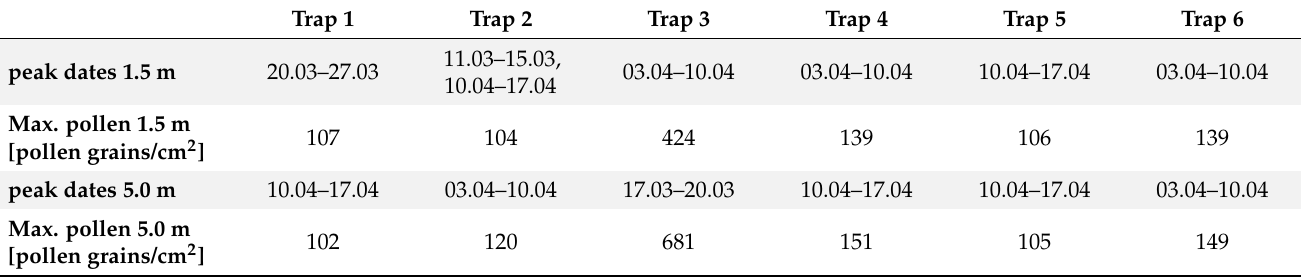
Figure 9. Pollen measurements obtained for the study site Emmendingen. The location of traps (marked with an “x”) and of the plantation (green rectangle) are highlighted at the top of the Table. For pollen catch, the size of the circles represents the order of the amount of pollen measured. For pollen impaction, the square represents the pollen trap, the red thick dashes indicate the direction where the most pollen was recorded, and the blue dashes show where the second most was recorded. Table 3. Peak dates and maximum pollen deposition for single traps at a height of 1.5 m and 5.0 m.